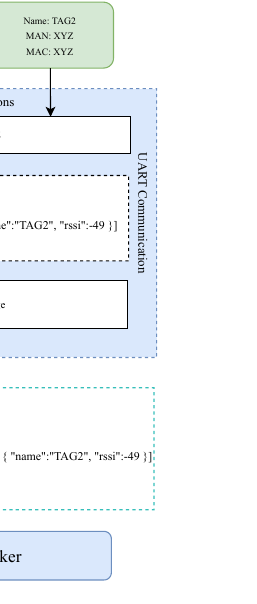
Figure 2. Communication architecture of the scanning stations (taken from [24]).